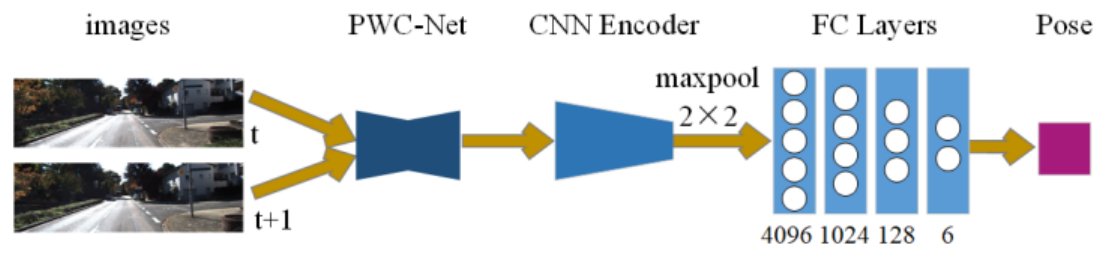
Figure 4. The architecture of LS-CNN-VO and LS-AE-VO models in their end-to-end form.